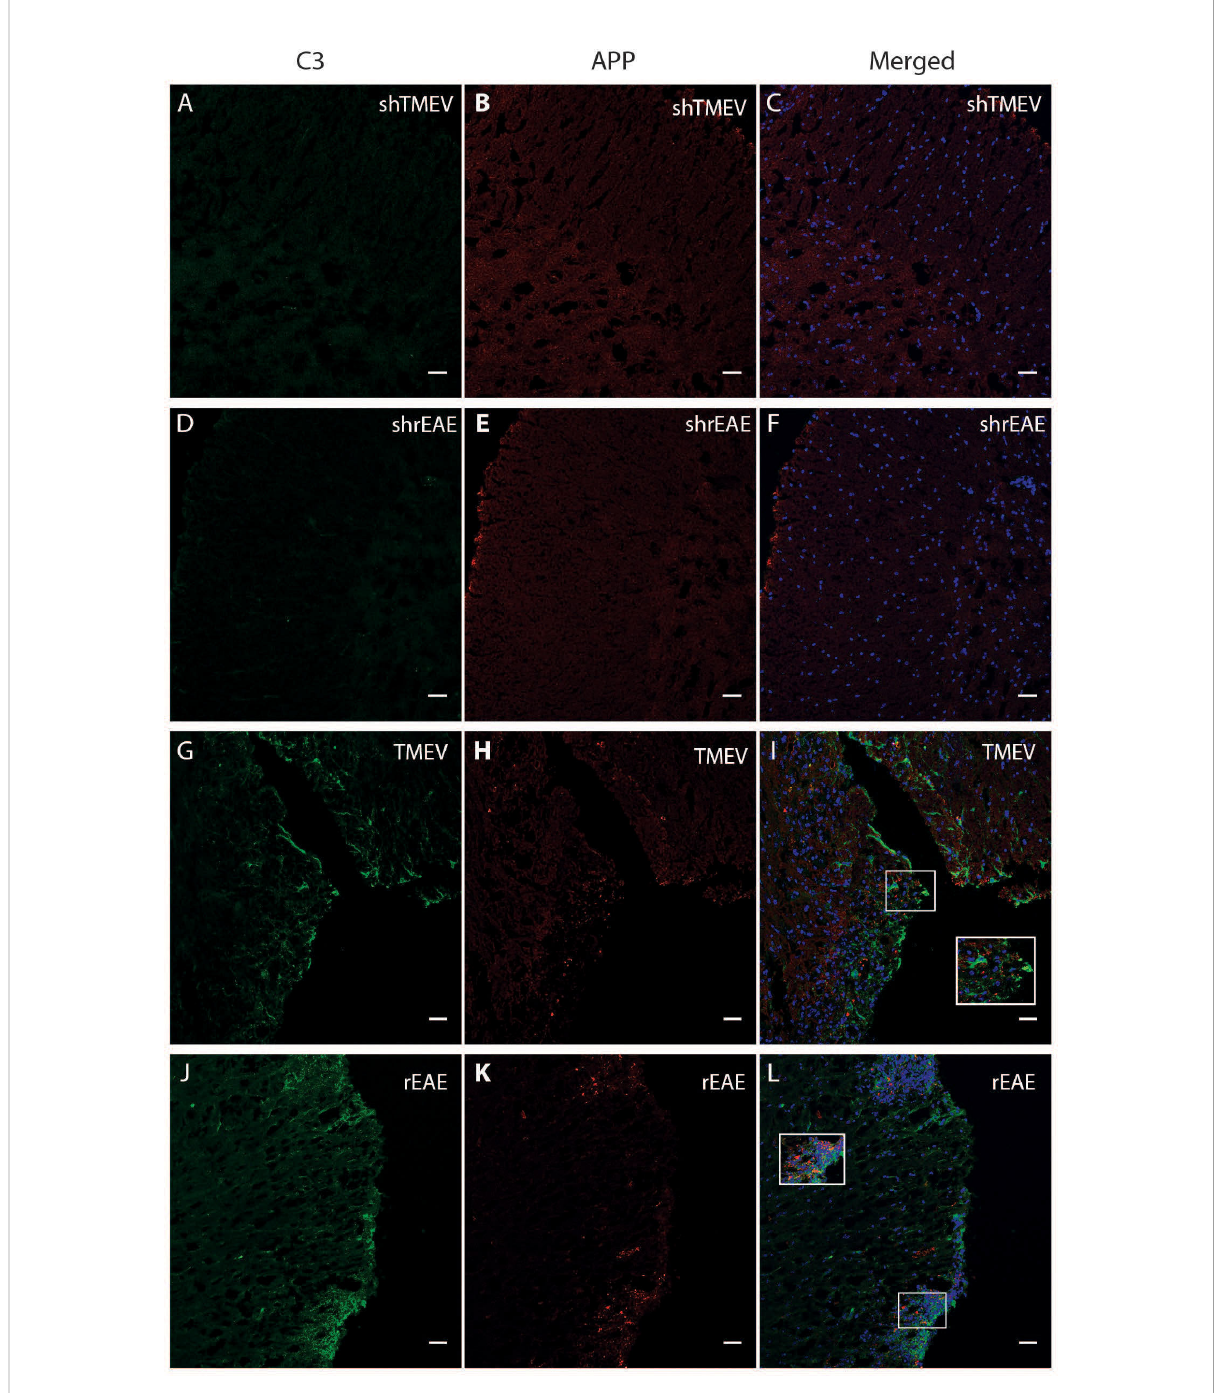
FIGURE 3 Colocalization of C3 and APP in the spinal cord of TMEV-IDD and rEAE mice. TMEV-IDD and rEAE mice were necropsied at ~120 dpi (chronic stage) and ~15 dpimm (acute relapse), respectively. Spinal cords were harvested for immunohistochemical analyses of the complement component C3 (A, D, G, J) and the axonal damage marker APP (B, E, H, K) to link complement activation and disease pathology. As expected, age-matched sham controls (A – F) show no obvious C3 (green) or APP (red) staining. In contrast, C3 and APP colocalize in both models (I, L) . Regions of interest were highlighted using inset images. Images are representative of 4-5 mice per group. Representative z stacks are shown and the scale bar = 100 m